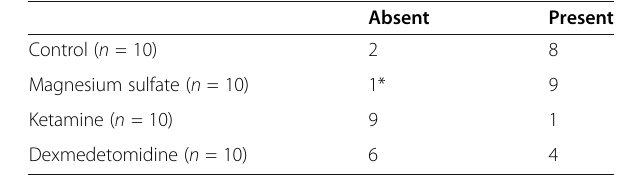
Table 4 Comparison of study groups in terms of presence of red neurons